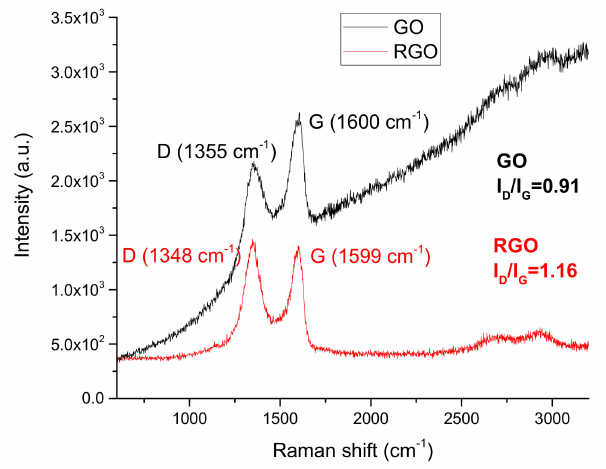
Figure 5. Raman spectra of the GO and RGO